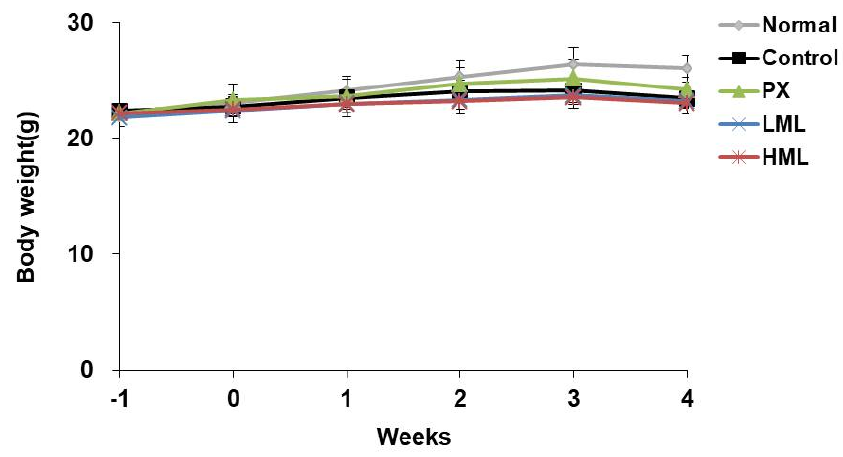
Figure 1. Effect of a mustard leaf (ML) extract on mouse body weight. Data represent means ± SEM ( n = 5). CRS—chronic restraint stress; PX—paroxetine; LML—low-concentration mustard leaf; HML—high-concentration mustard leaf.